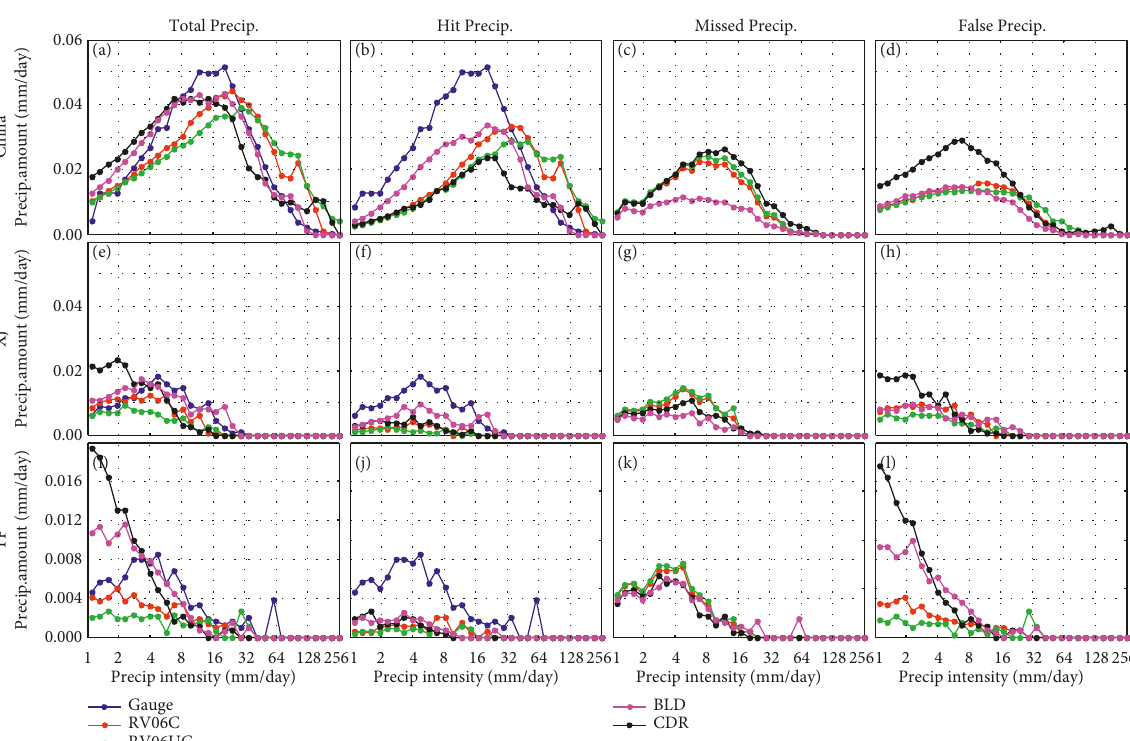
Figure 15: The daily intensity distribution of the total, hit, missed, and FP in winters for the period from March 2014 to June 2018 over Mainland China and XJ and TP subregions. The total precipitation of gauge (blue line) is also shown in the first two columns for comparison.